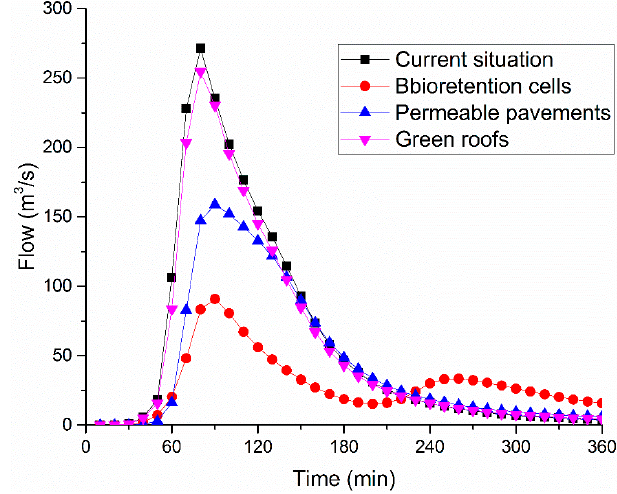
Figure 9. Outlet flow process under P = 10 rainfall. When P = 5, the peak of outlet flow appears at the 82nd minute (225.97 m 3 /s) with- out LID controls. Under the scheme with bioretention cells, the peak was delayed for 10 min compared with the current situation, and the value of peak flow was reduced by 157.22 m 3 /s (69.58%). Under the scheme with permeable pavements, the peak was delayed for 7 min, and the value of the peak flow was reduced by 107.75 m 3 /s (47.68%). Under the scheme with green roofs, the peak was delayed for 4 min, and the value of the peak flow was reduced by 16.58 m 3 /s